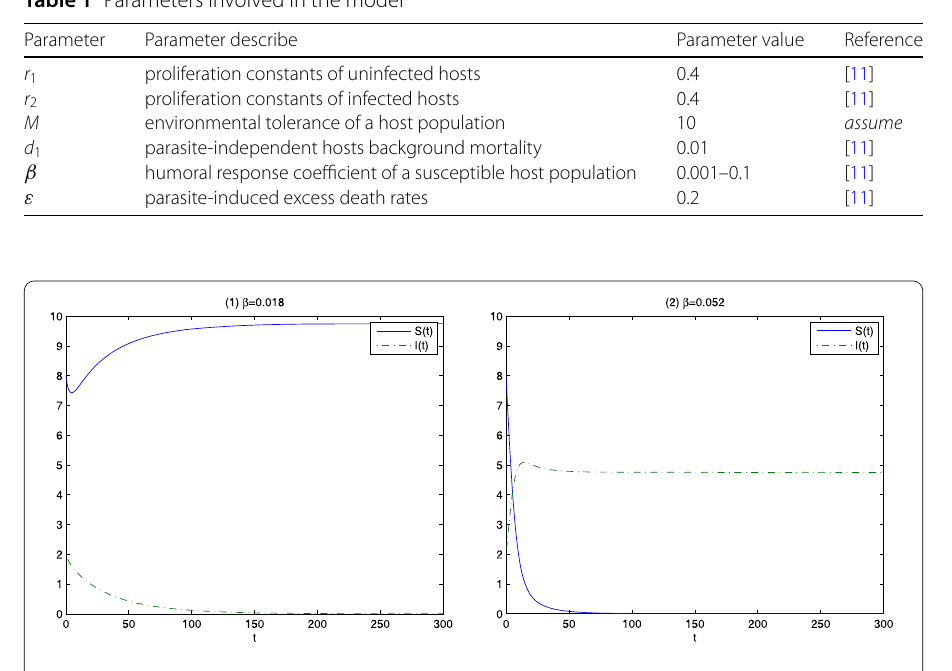
Figure 1 Numerical simulations of system (2) with parameter values r 1 = r 2 = 0.4, d 1 = 0.01, ε = 0.2, M = 10